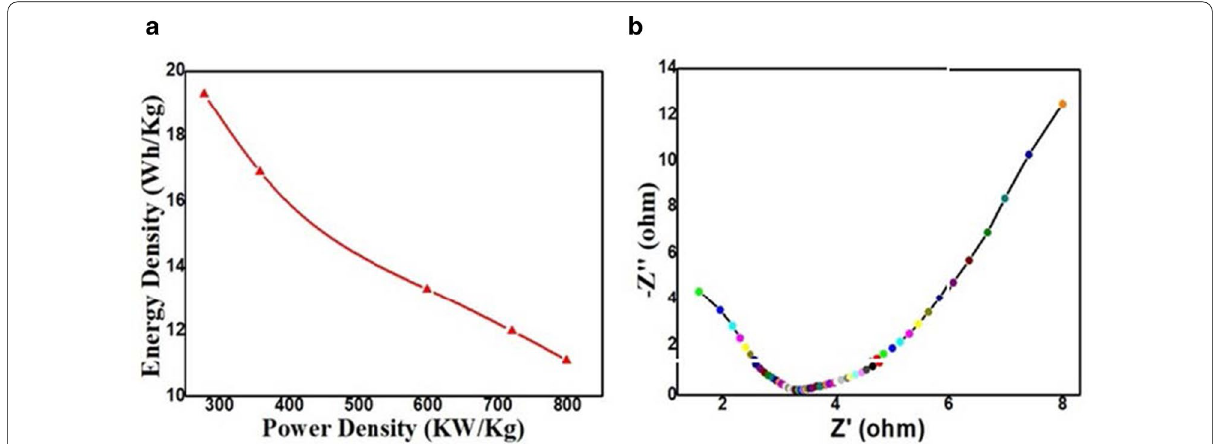
Fig. 8 a Ragone plot for the GCD capacitor and b Nyquist plot of impedance for as-synthesized